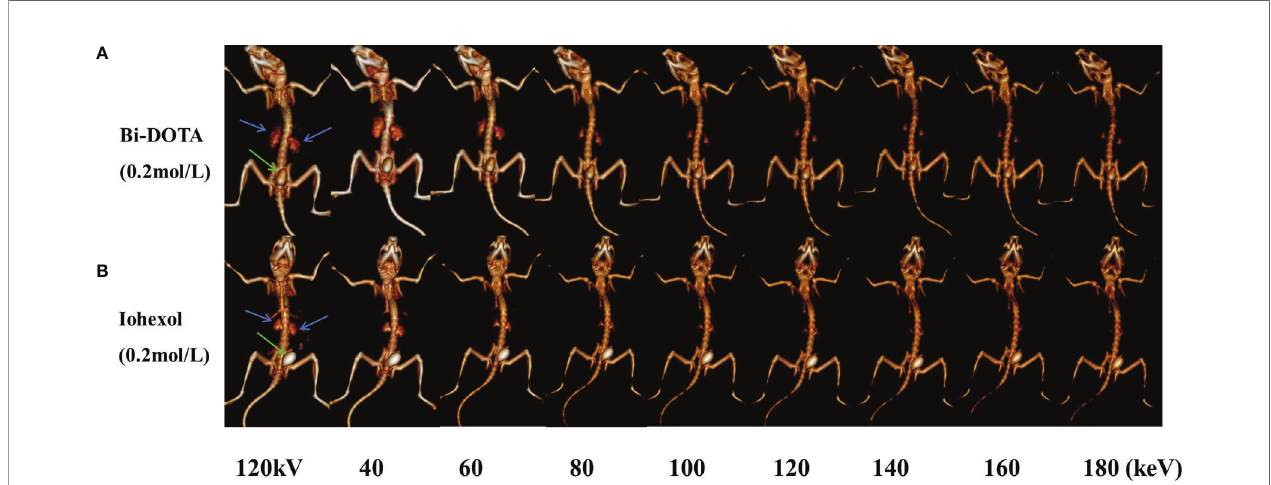
FIGURE 5 | In vivo spectral CT urography imaging under different energies using 0.2 mol/L Bi-DOTA (A) and iohexol (B) (blue arrows represent kidney and green arrows represent